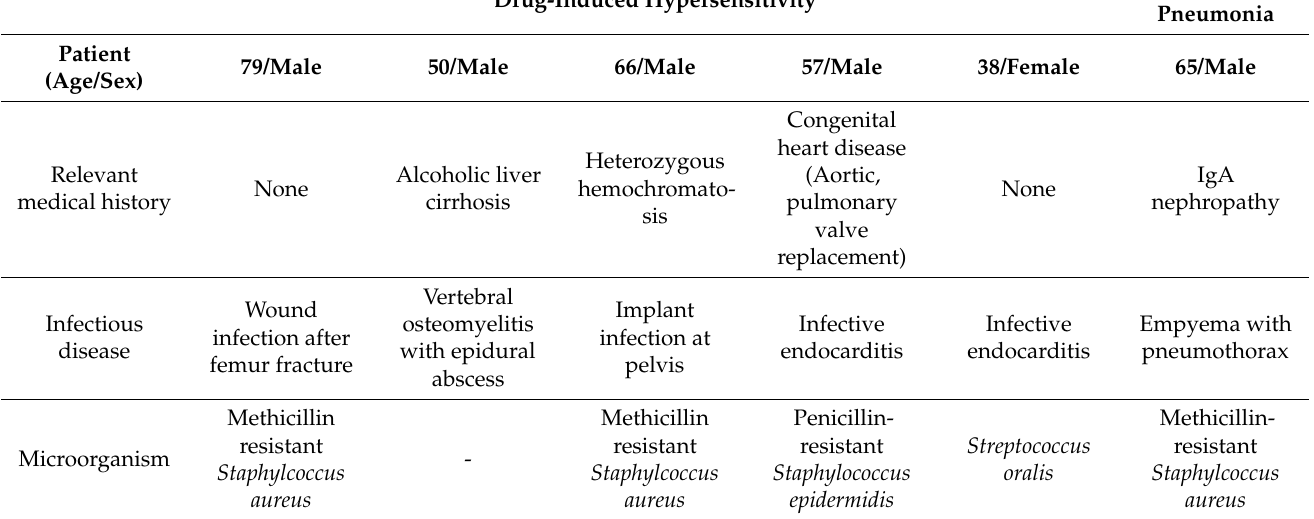
Table 1. Drug-induced hypersensitivity and eosinophilic pneumonia cases associated with adverse pulmonary reactions and vancomycin